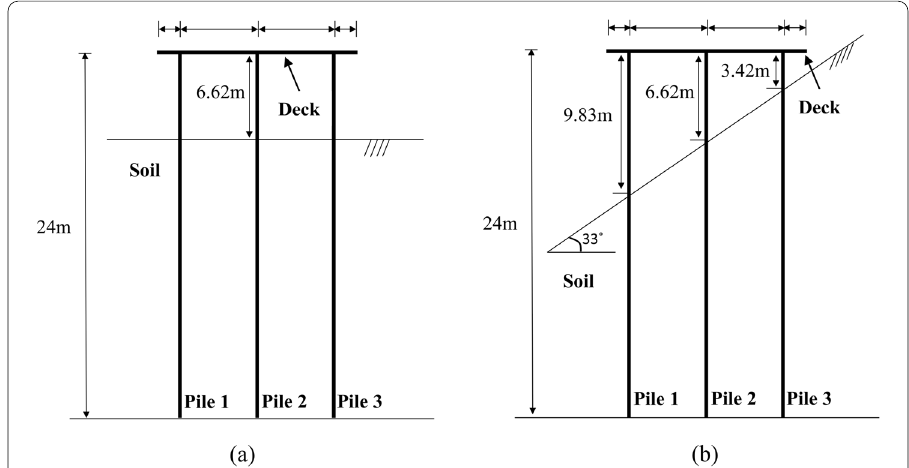
Fig. 3 Dynamic centrifuge prototypes: a HA45, b